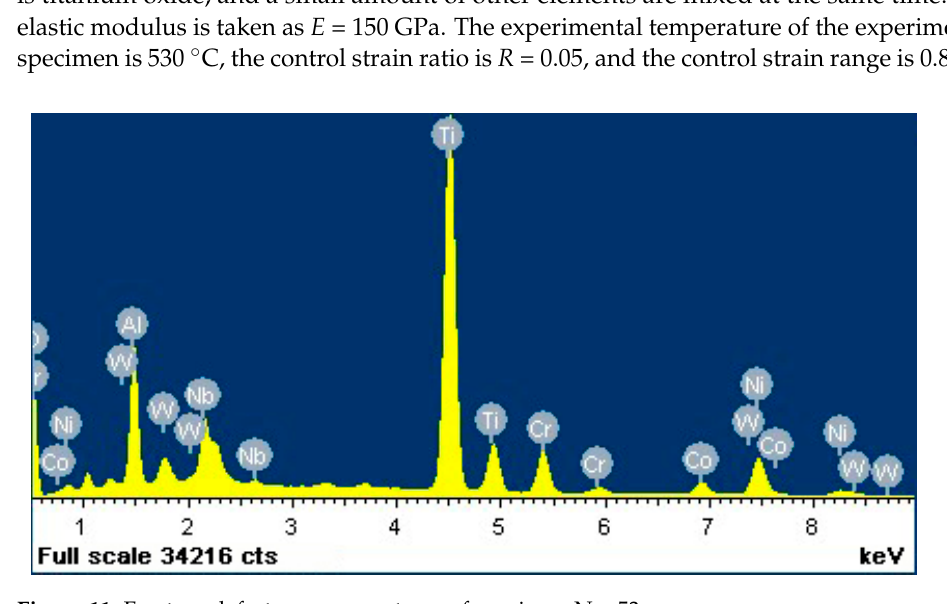
Figure 11. Fracture defect energy spectrum of specimen No. 53. Table 9. Fracture defect composition of specimen No. 53.